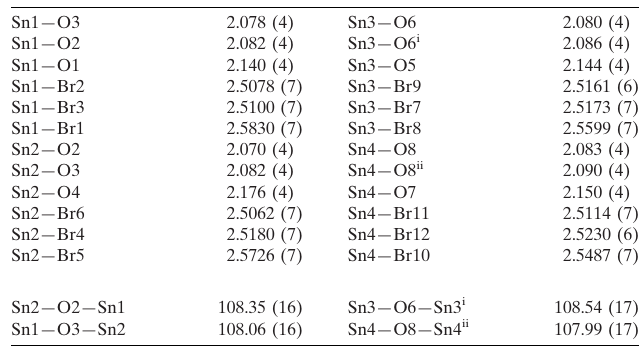
Selected geometric parameters (A˚ , (cid:3) ).